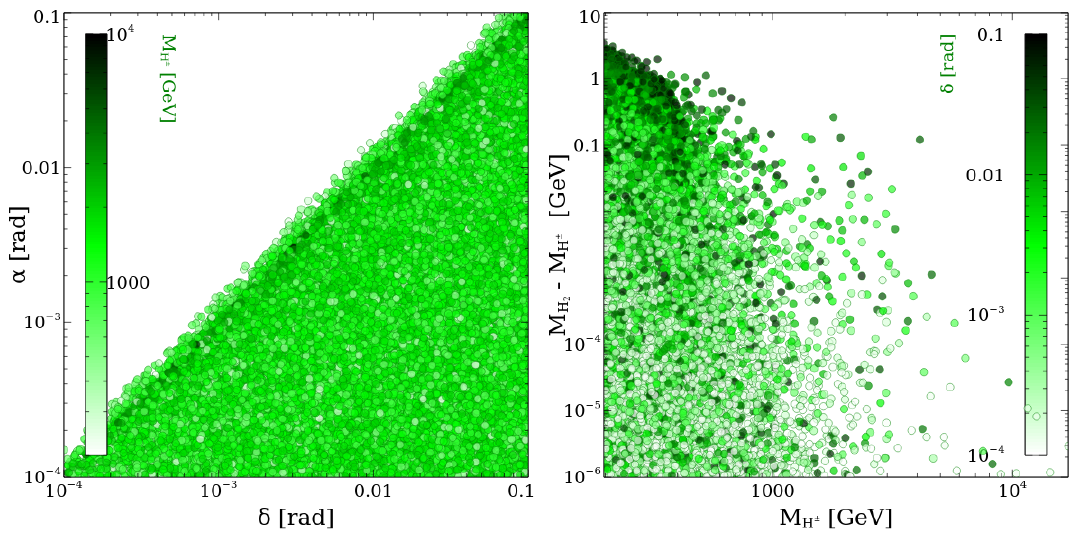
Figure 1 . Left: scatter plot in the α − δ plane after imposing the perturbative limit on the quartic couplings λ 4 π , the trivial bound from below, λ 0 , and spontaneous and induced vevs i ≤ i > conditions µ 2 = M . Right: scatter plot in the ( M ) — M plane , µ 2 > 0 , here M H 2 H 2 − M H + H + H + h ∆ after imposing the same constraints. The color bars indicate the variation of M and δ in the left H ± and right panel,